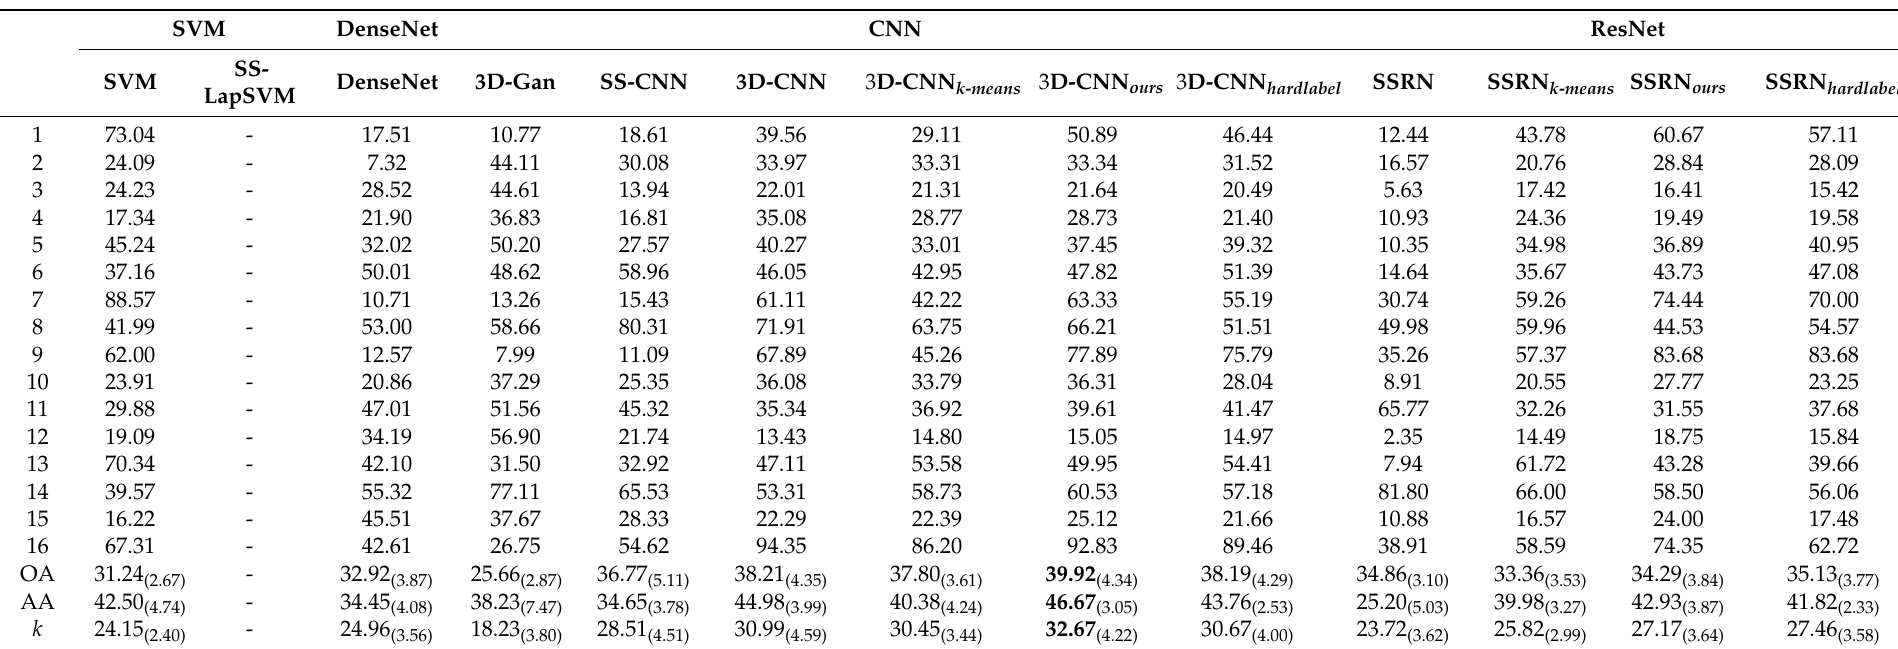
Table 10. Classification accuracy (%) for all methods with one training sample on the Indian Pines dataset. The symbol ‘-’ means the method is failed to